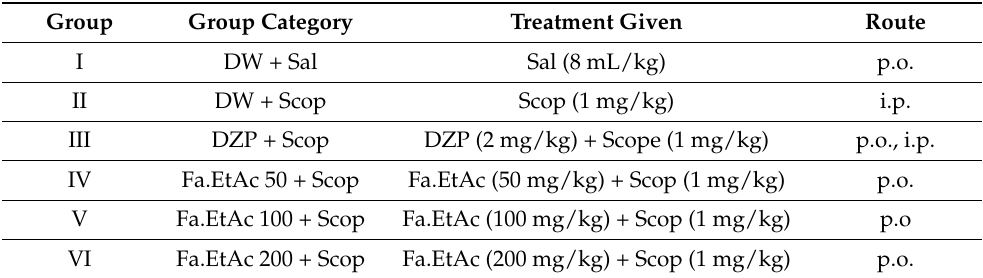
Table 1. Experimental design showing dosing